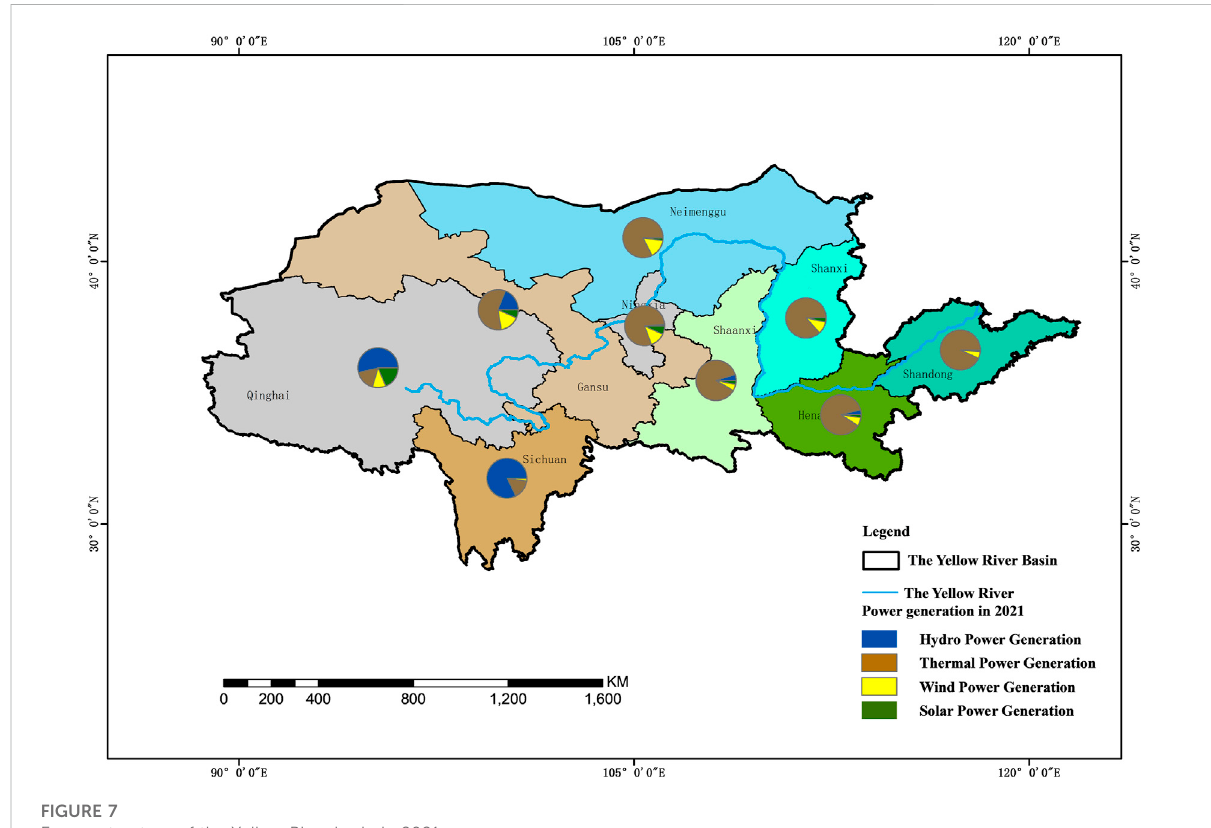
FIGURE 7 Energy structure of the Yellow River basin in